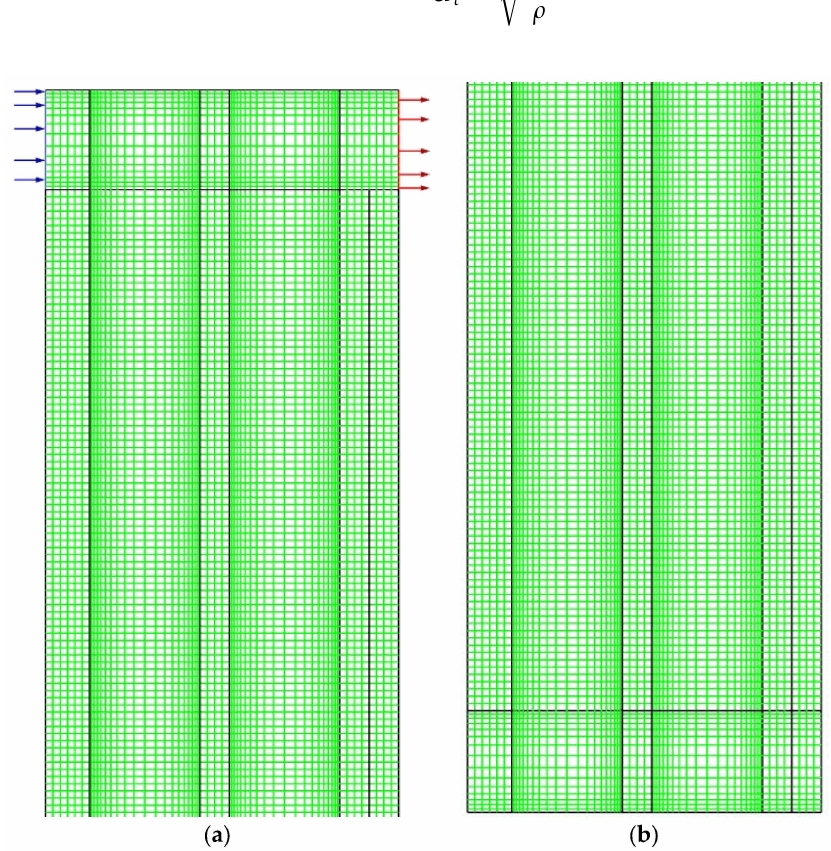
Figure 5. Mesh architecture adopted in the heating window with inlet (blue arrows), outlet (red arrows): ( a ) upper zone; ( b ) lower